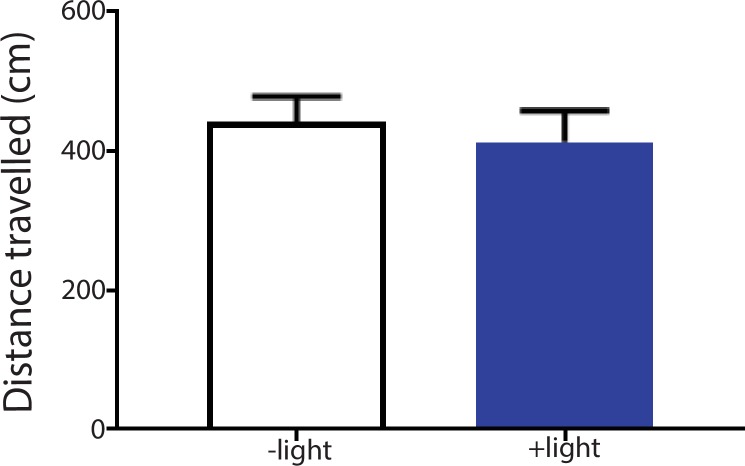
Activation of the ACC did not alter locomotion.We measured locomotion over 10 min for rats that received optogenetic activation of the ACC. Light was turned on for 3 s every 10 s during the locomotion test. Light treatment did not change locomotor activities during the test. n = 8; p=0.6517, paired Student’s t test.